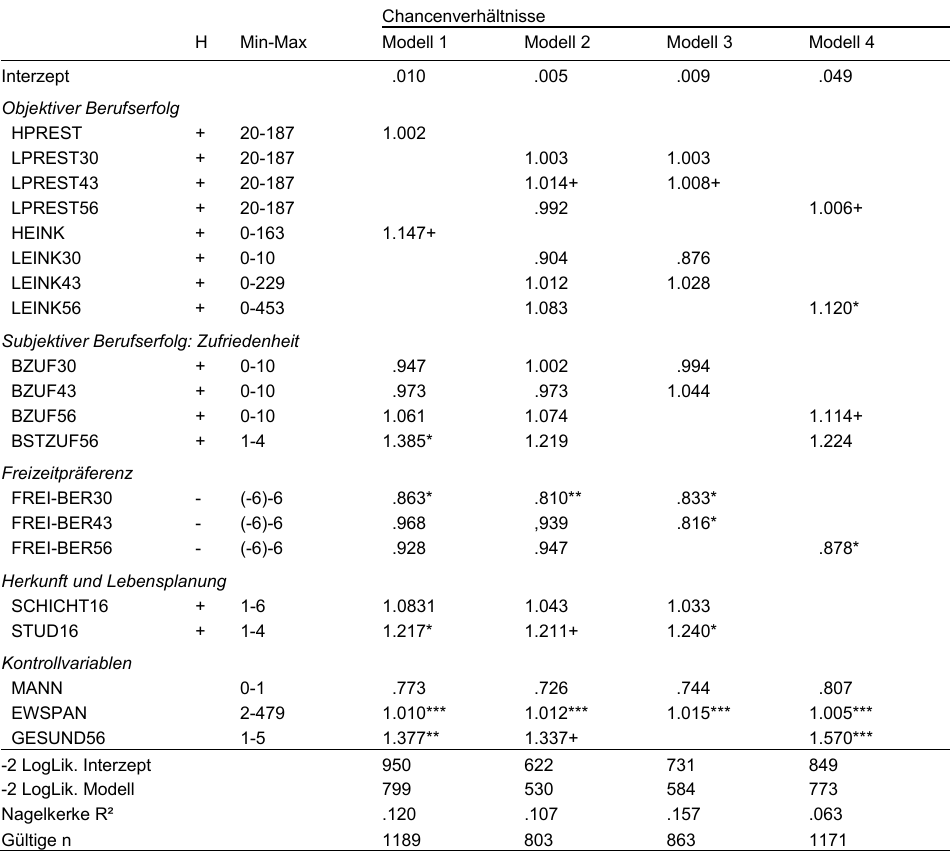
Tabelle 4: Logistische Regression von A-BERTAET auf Berufserfolg